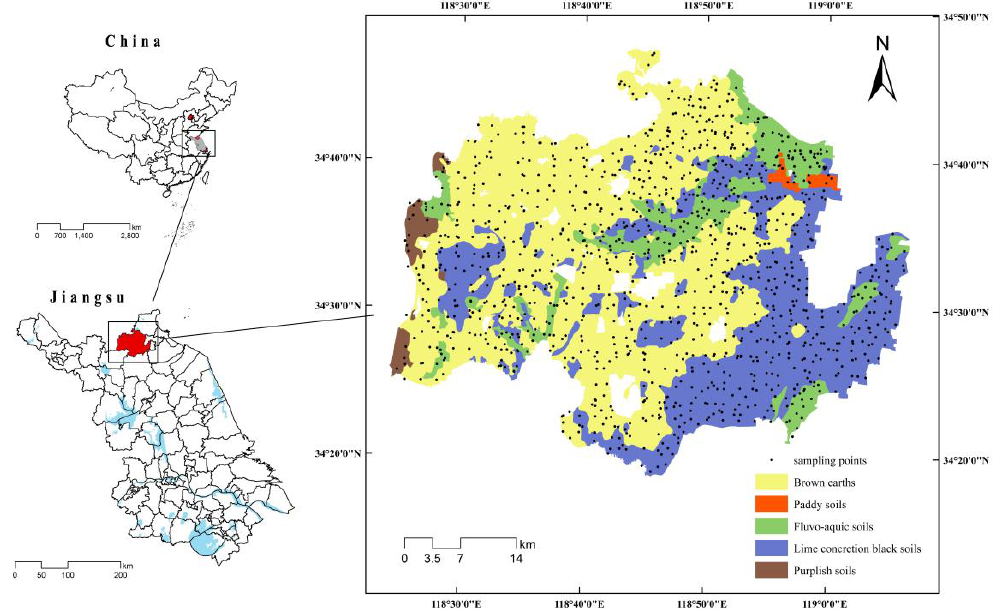
Figure 1. Location of the study area and sample points.